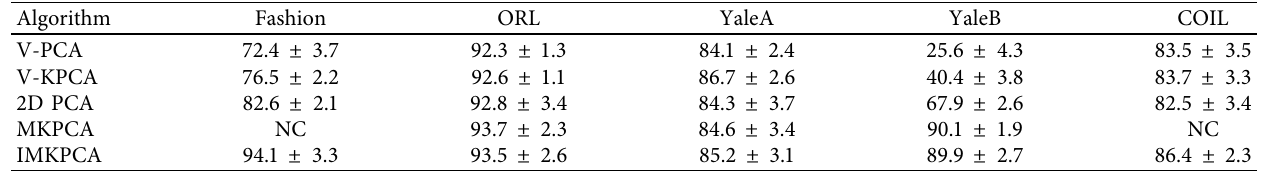
Figure 7: Image samples from chosen databases. From top to bottom, images of two objects from (a) Fashion MNIST, (b) YaleA, (c) ORL, (d) COIL, and (e) Extended YaleB, respectively; each object shows ten samples only. Table 2: Recognition rates for different